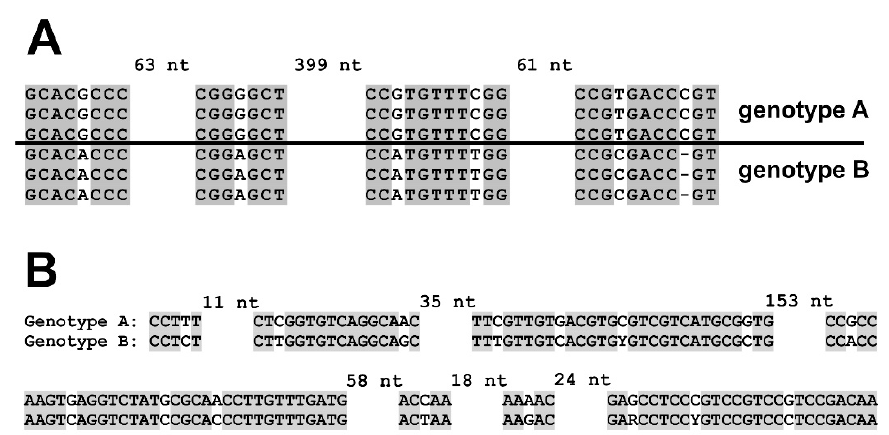
Figure 1. Sequence diversity between Ganoderma resinaceum genotypes. ( A ) Comparison of aligned ITS sequences of G. resinaceum genotypes A and B; ( B ) comparison of aligned partial translation elongation factor 1- α ( tef1- α ) sequences of G. resinaceum genotypes A and